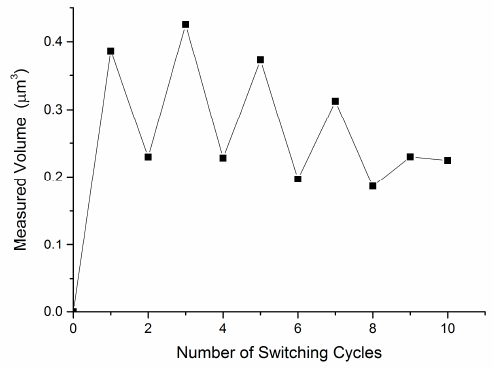
Figure 8. The evolution of material deposited on the lower contact surface over 10 cold switching cycles.